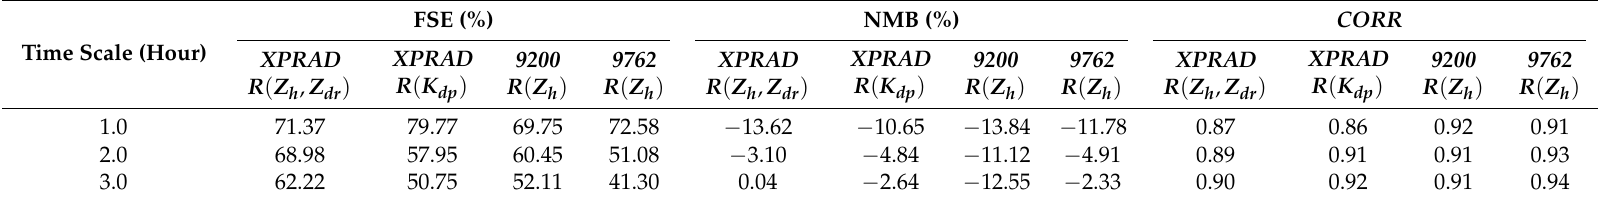
Table 6. Assessment of R ( K dp ) , R ( Z h , Z dr ) and R ( Z h ) for fifteen rainfall events under four scales of accumulated time